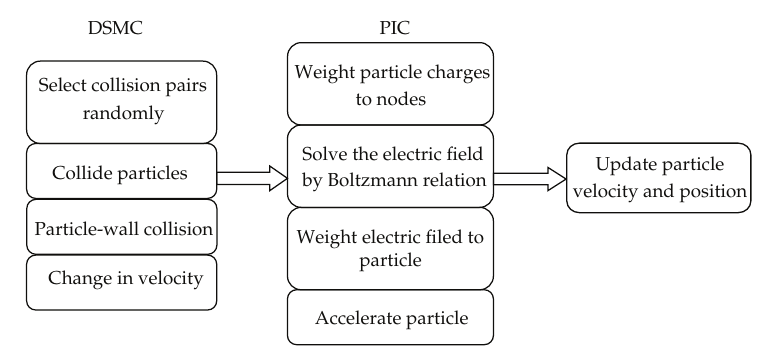
Figure 1: One time step of the PIC-DSMC